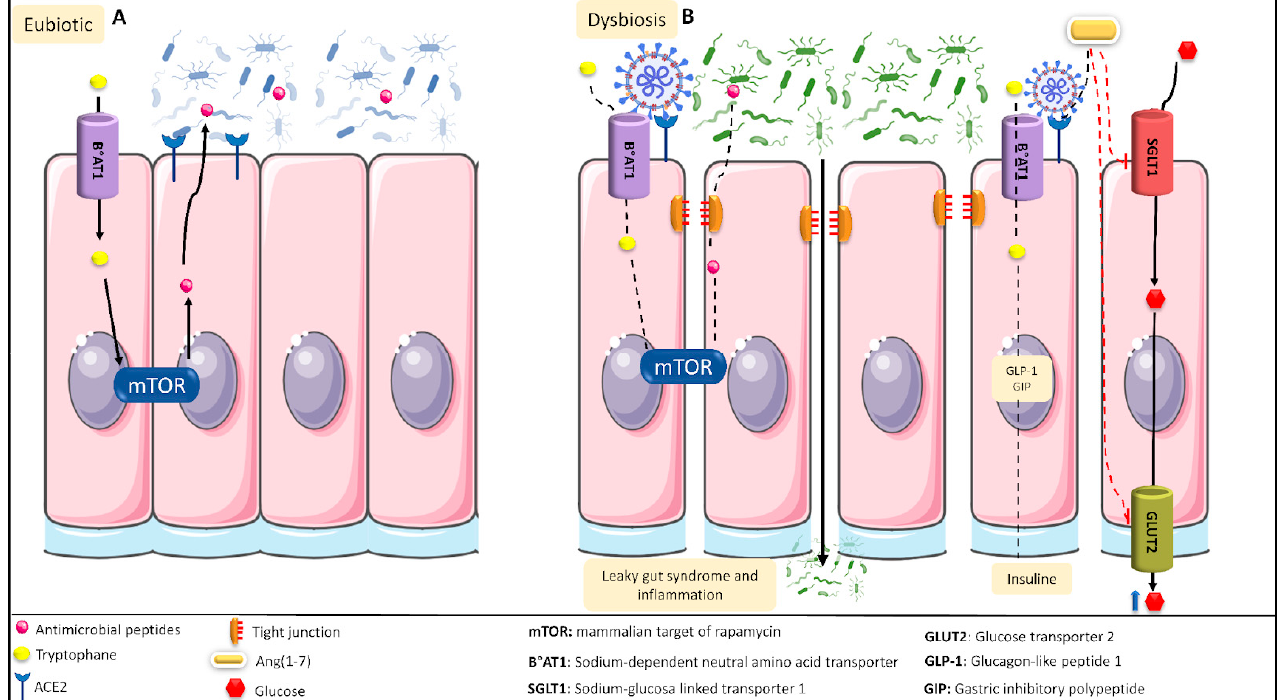
Figure 1. Intestinal eubiotic and SARS-CoV-2-induced intestinal dysbiosis. ( A ) In a general intestinal environment in eubiotic conditions, tryptophan can enter into the intestinal tract’s epithelial cells, generating the production of antimicrobial peptides that will regulate the intestinal microbiota. In addition, ACE2 can convert Ang II into Ang (1-7), which, after binding to its receptor, Mas, blocks intestinal glucose transport. ( B ) The various proinflammatory mechanisms caused during SARS- CoV-2 infection generate an intestinal dysbiosis condition. Under this condition, SARS-CoV-2 can block the B ◦ AT1 receptor, preventing both the passage of tryptophan into the epithelial cells and the production of antimicrobial peptides. SARS-CoV-2 can also disrupt the tight junctions of the cells, producing leaky gut syndrome and inflammation. Moreover, SARS-CoV-2 binds to the ACE2 receptor, preventing the formation of Ang (1-7) and favoring the activity of the SGLT1 as well as GLUT2 transporters, increasing the intestinal glucose